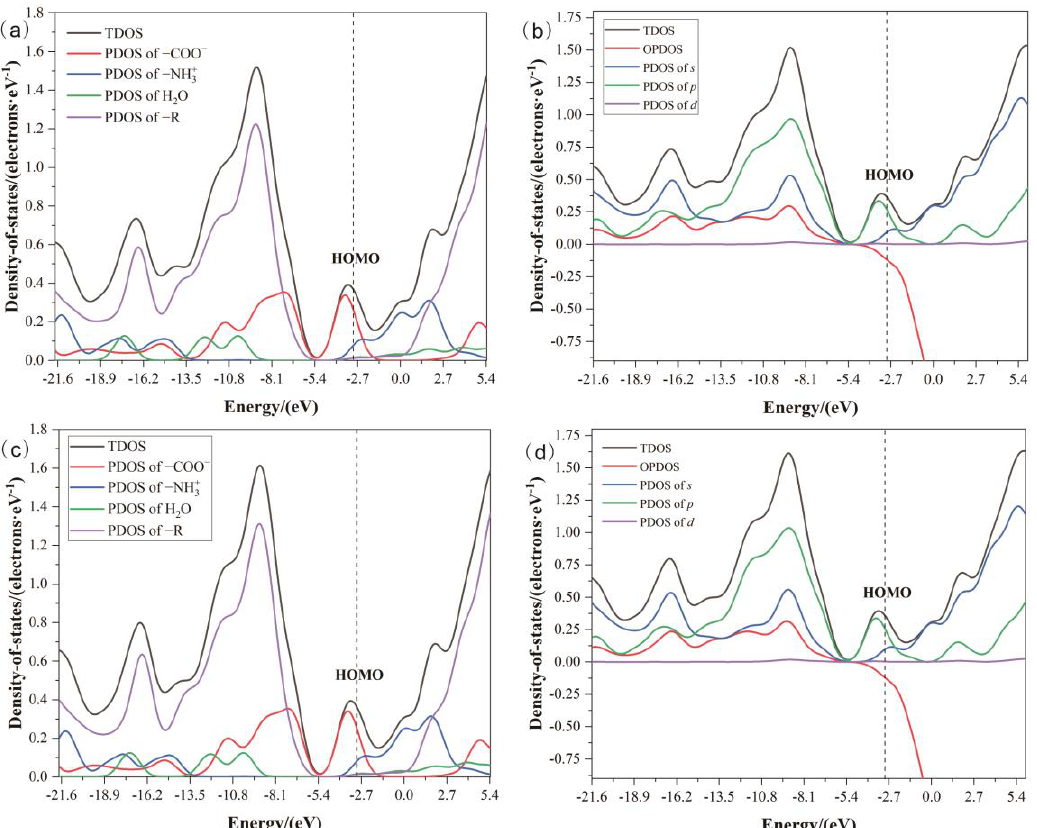
Figure 13. The density of states distribution of the title compounds: ( a ) calculated total DOS and PDOS of different functional groups of 3C16; ( b ) calculated total DOS and PDOS of different angular momentum of 3C16; ( c ) calculated total DOS and PDOS of different functional groups of 3C17; ( d ) calculated total DOS and PDOS of different angular momentum of 3C17.